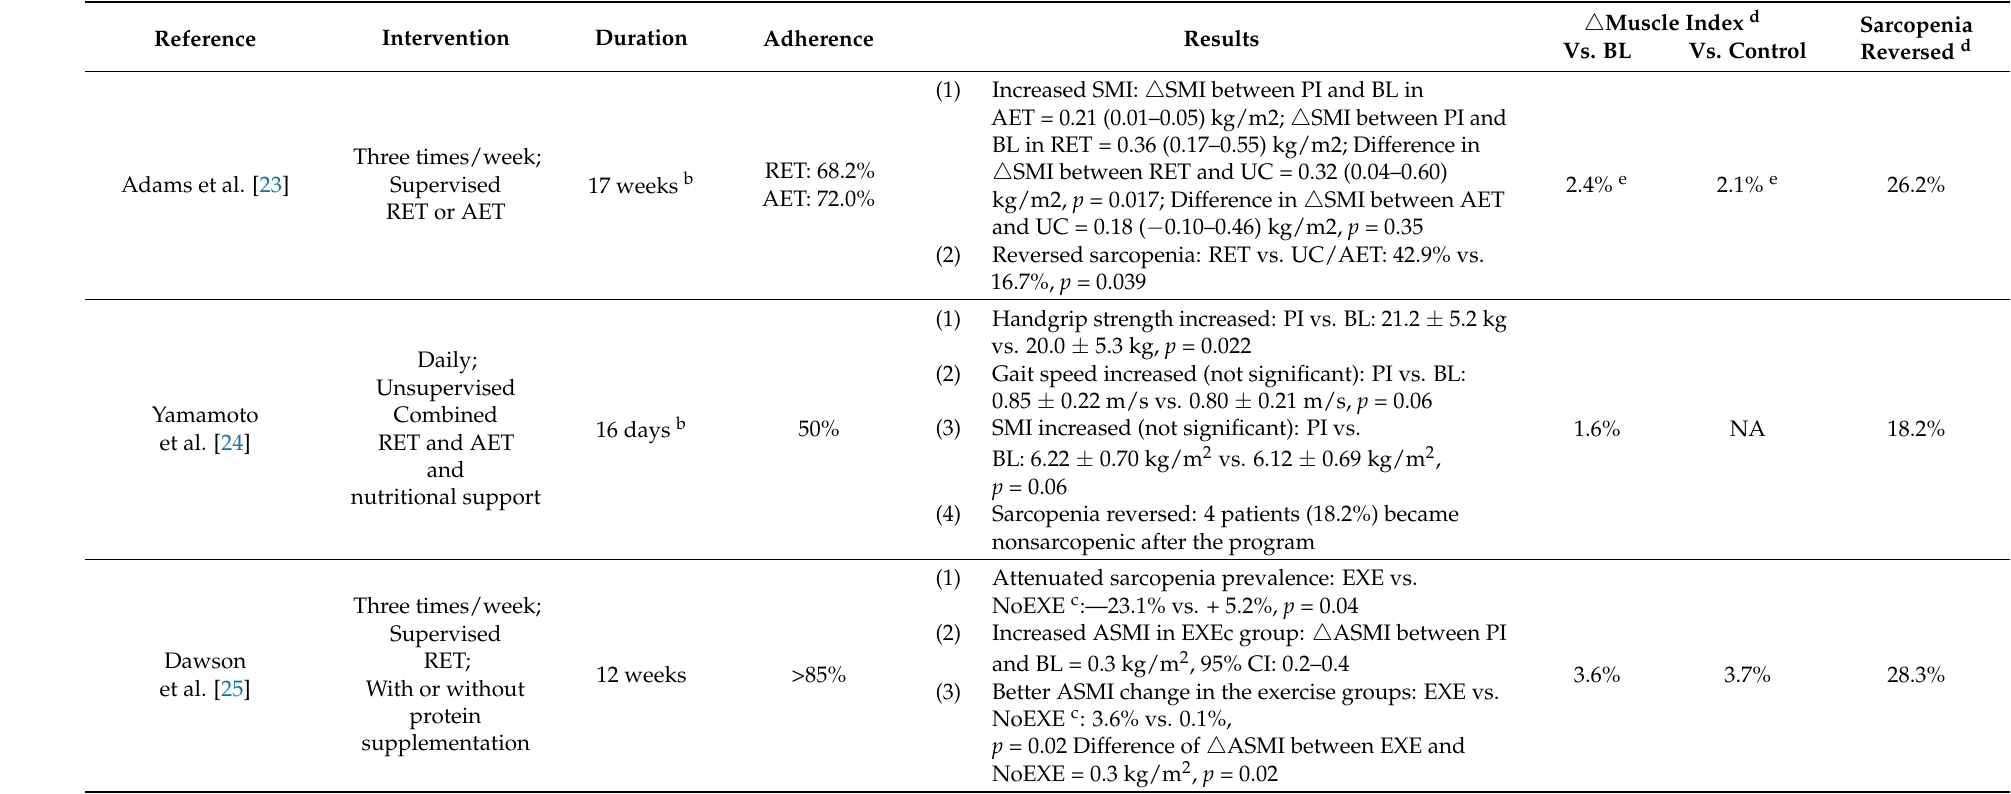
Table 3. Study design and results